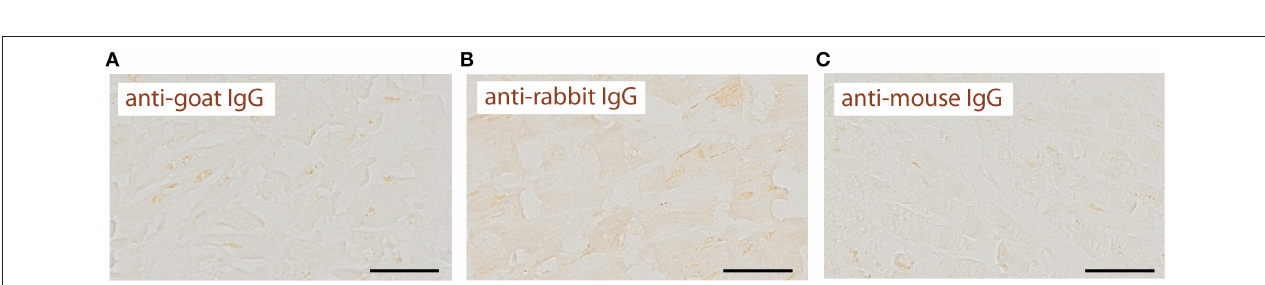
FIGURE 5 | Negative control staining shows no signal. Immunostaining of cardiac biopsies of SCD victims without primary antibodies shows no signal with anti-goat (A) , anti-rabbit (B) or anti-mouse (C) IgG secondary antibodies. Scale bar = 50 µ m. These images serve as negative controls for images in Figures 1 – 4 .